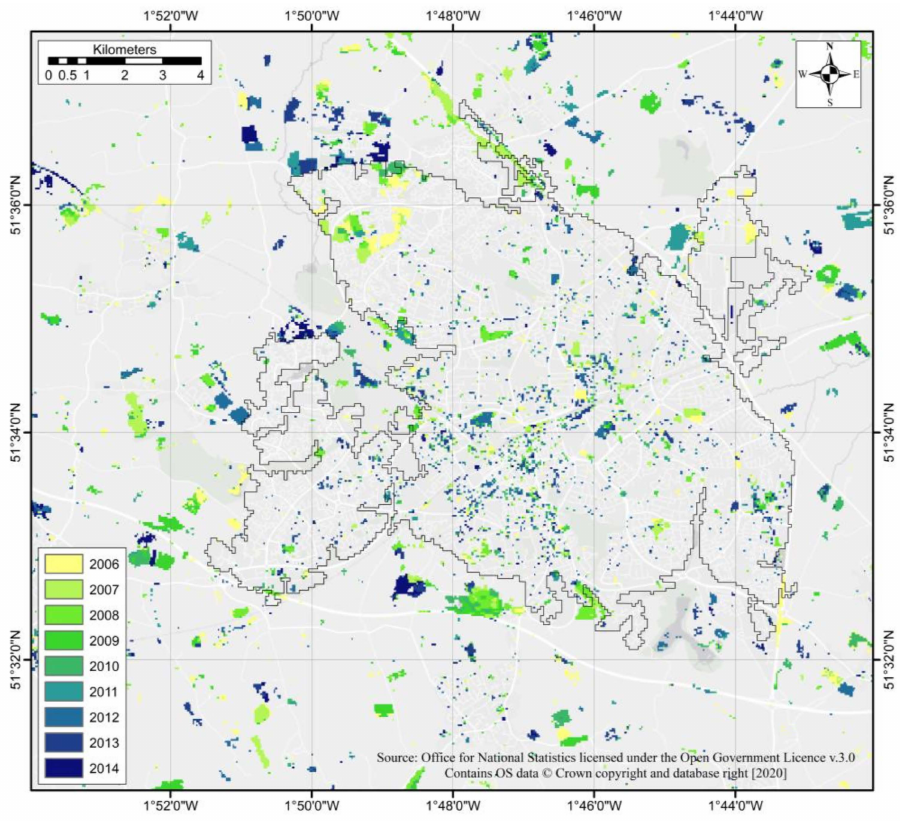
Figure 5. Land over change map produced for the period of 2006–2015. Changes outside of these known areas of urban growth are found within both the urban and rural environments. In the urban environment, identified changes are mainly in small patches (groups of contiguous pixels that change at the same time) or isolated pixels, whereas in the rural areas change occurs in predominantly large patches (Figure 5).